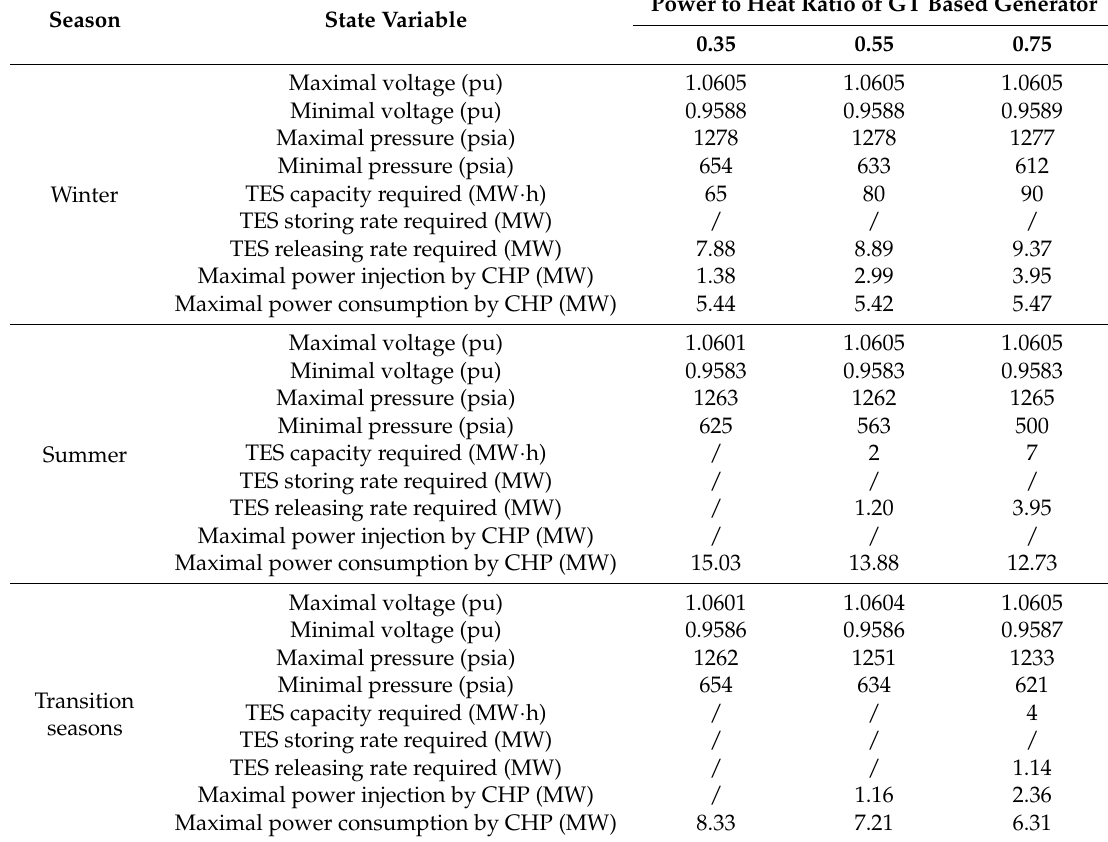
Table 4. System states under different power to heat ratio based CHP generations. (Following the proposed